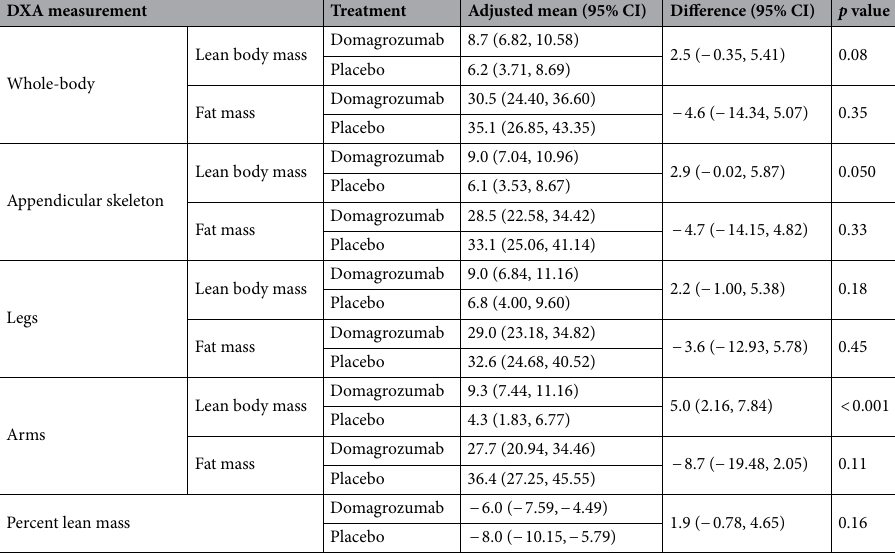
Table 2. Change from baseline in lean body mass and fat mass after 48 weeks of treatment. Data are % change from baseline. All results were calculated using a mixed model of repeated measures. CI Confidence interval; DXA Dual-energy X-ray